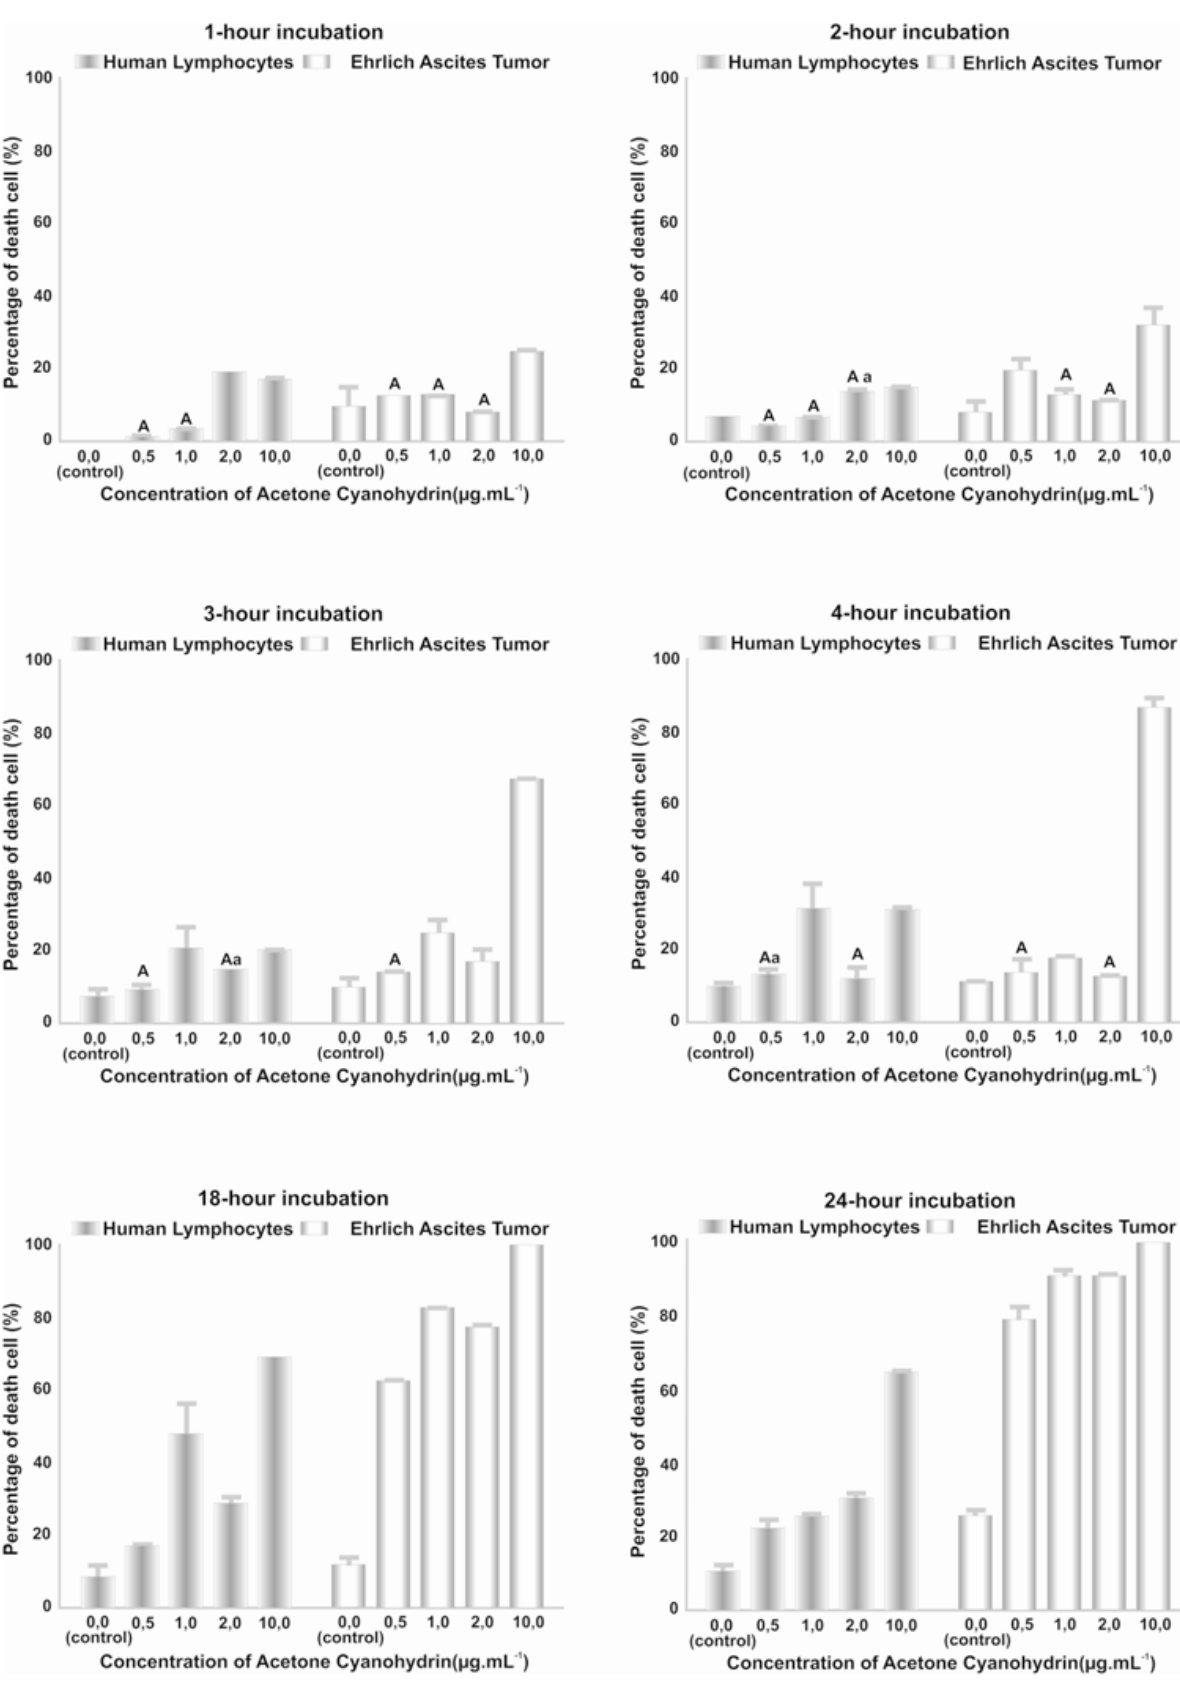
FIGURA 1 - Percentage of mortality of human lymphocytes and cells of the Ehrlich ascites tumor after incubation with acetone cyanohydrin. Results are the mean ±SD for two independent experiments. A - present no significant difference in the control (p>0.05). a- present no significant difference when compared with cells of EAT